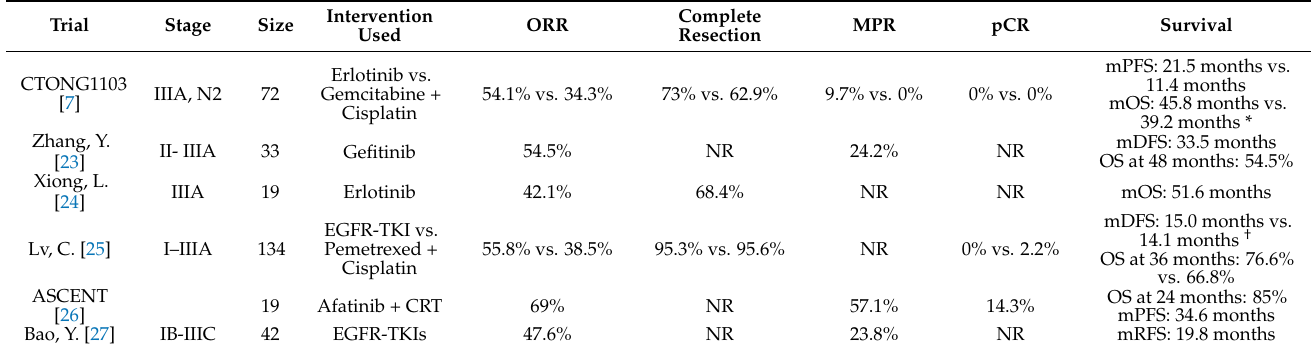
Table 2. Phase II clinical trials of neoadjuvant-targeted